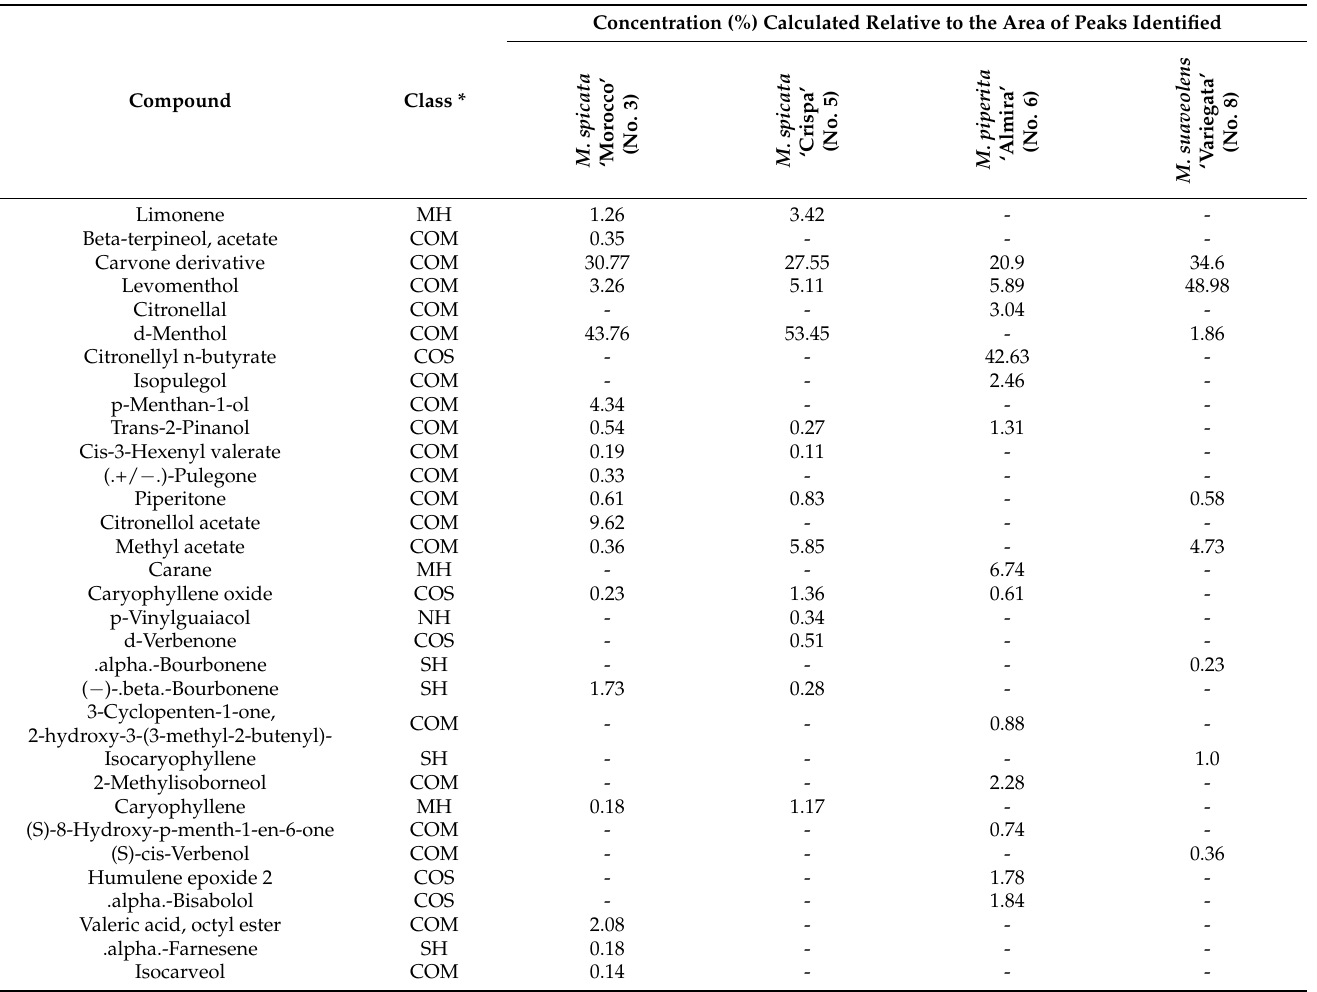
Table 3. Chemical composition of the water mint extracts.